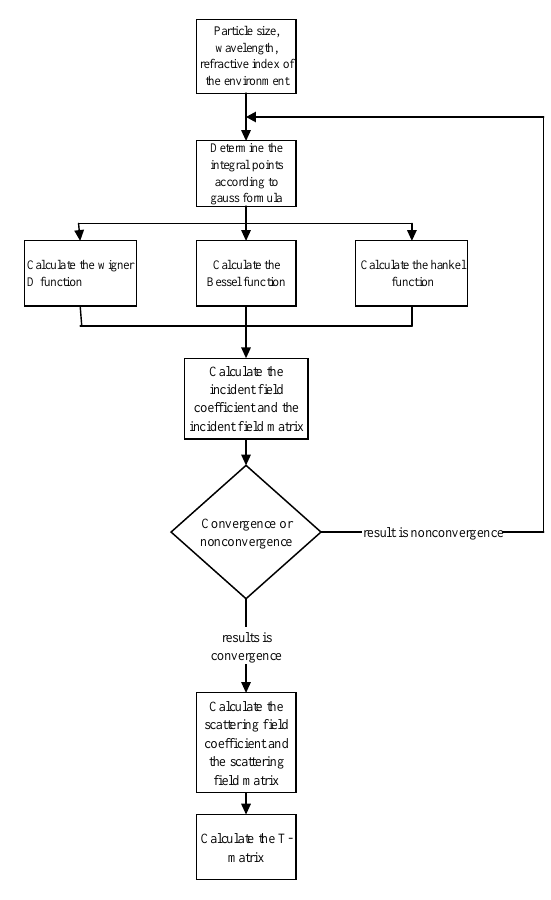
Figure 1 . The process of calculating the T-Matrix Figure 1 is the process of calculating the T-matrix of the incident field and scattering field. The key to the calculation is whether the incident field coefficient converges.